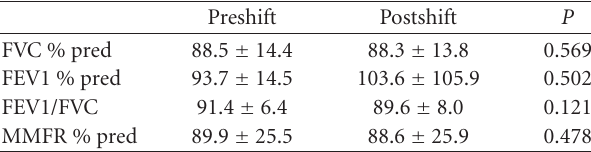
Table 2: Pre-and postshift spirometric values of workers.